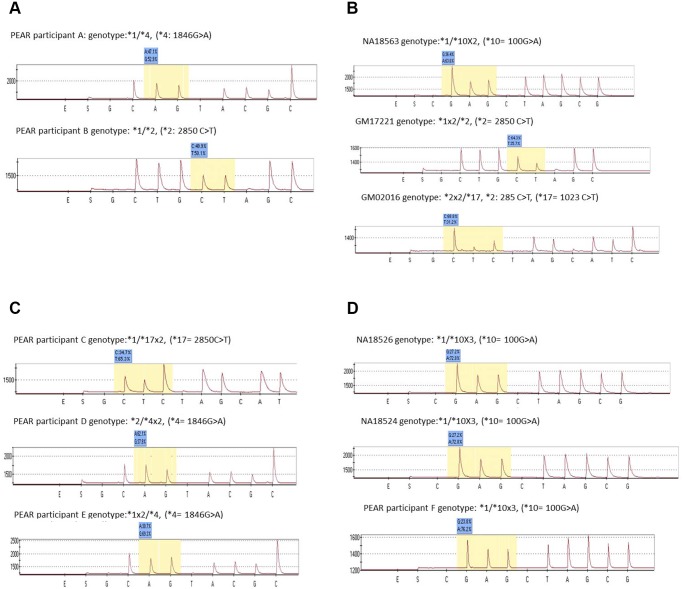
The pyrogram along with genotype calls and CNV (duplication/multiplication) and allele quantification (percent) for known and unknown Corriel and clinical DNA samples are shown in Fig. 1A, 1B, 1C, and 1D.
A. Normal CYP2D6 gene (no duplication). B. Coriell Samples with 3 known CYP2D6 gene copies. The duplicated allele percentage ranges from 62% to 70%. C. Clinical samples with different CYP2D6 gene copies. The duplicated allele percentage range from 62% to 70%. Without defining the duplicated allele, the predicted phenotypes for these individuals are ambiguous. D. Corriel and Clinical samples with 4 CYP2D6 gene copies. The alleles with the multiplication (3X) show a percentage ranging from 72% to 76%.